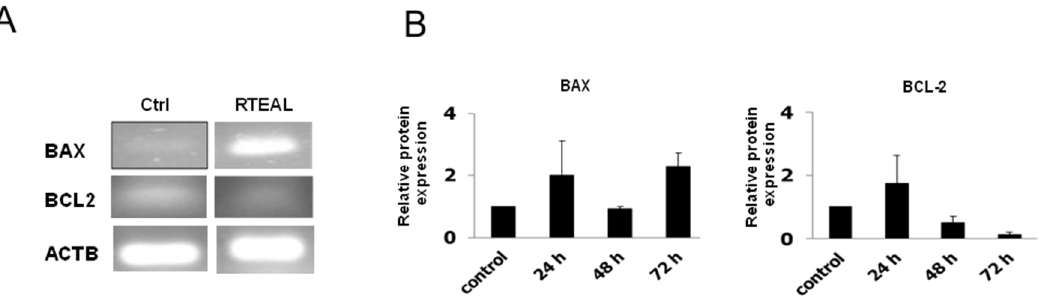
Figure 4. RTEAL alters the mRNA and protein expression of BCL-2 and BAX. MCF-7 cells were treated with 28 µg/mL of RTEAL for 24, 48 and 72 h. ( A ) RT-PCR results of cells treated for 72 h. ( B ) The relative protein expression was quantified after normalizing with β-tubulin and presented as mean ± SEM from three independent experiments.